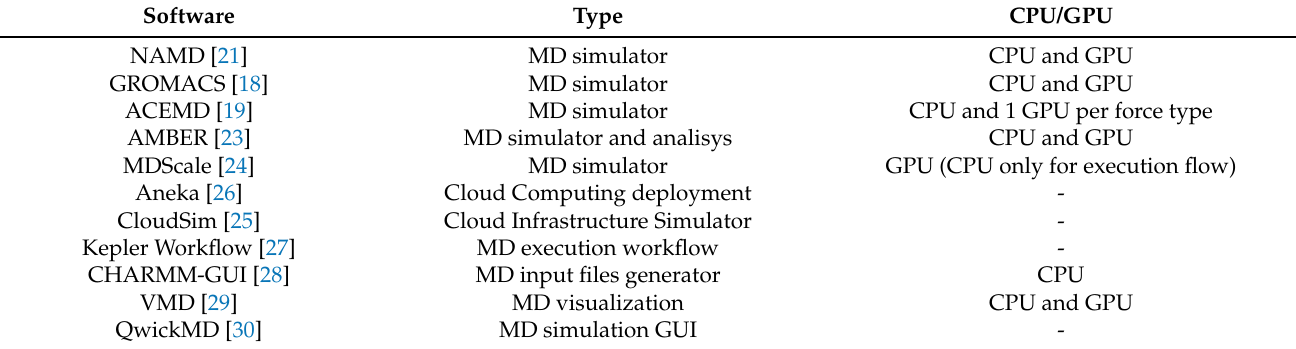
Table 1. Summary of MD simulators and cloud computing related